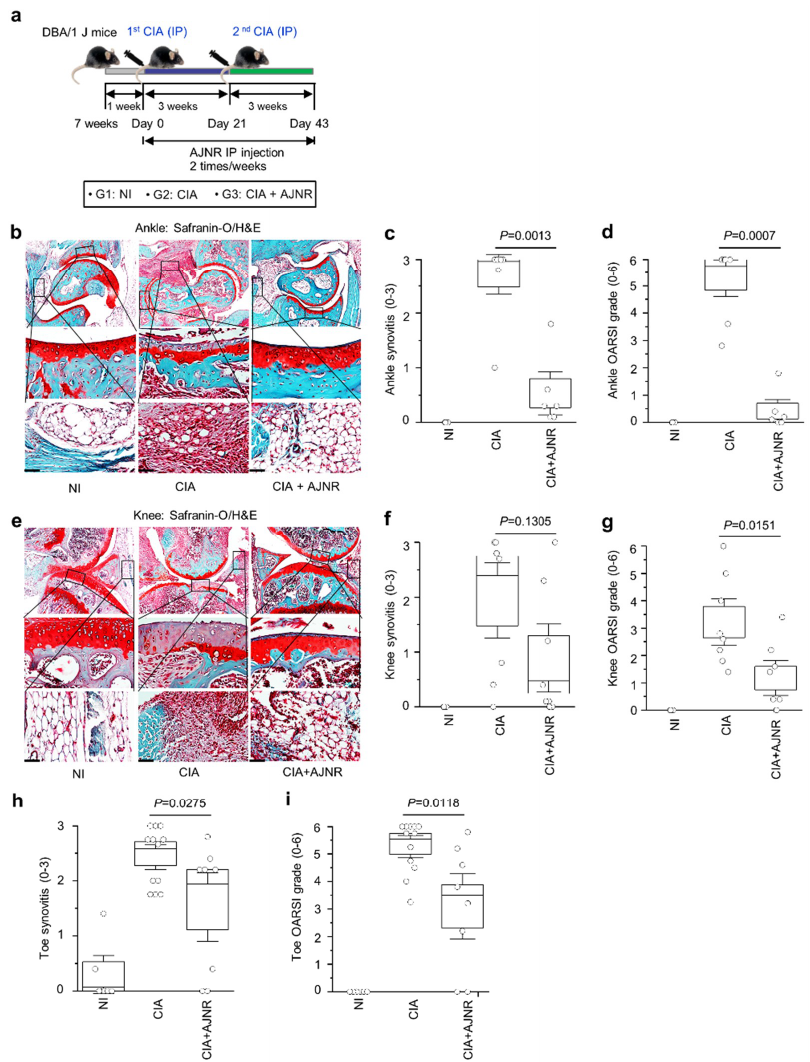
Figure 5. Inhibitory effects of AJNR against collagenase-induced arthritis (CIA)-induced cartilage degeneration and synovitis. First, CIA models were established using 10-week-old DBA/1 J mice. During arthritis induction, AJNR intraperitoneal (IP) injections were administered (2 times per week for 6 weeks). ( a ) The scheme of AJNR treatment in the CIA mouse model. ( b ) Representative Safranin-O and hematoxylin and eosin stain (H&E) staining images of ankle cartilage degeneration and synovial inflammation, respectively, in the non-immunized (NI), CIA, and AJNR-treated CIA mice. Scores of synovial inflammation ( c ) and Osteoarthritis Research Society International (OARSI) ( d ) in the ankle are presented ( n ≥ 4 mice per group). ( e ) Representative Safranin-O and H&E staining images of knee cartilage degeneration and synovial inflammation, respectively, in NI, CIA, and AJNR-treated CIA mice. Scores of synovial inflammation ( f ) and OARSI ( g ) in the knee are presented ( n ≥ 4 mice per group). Scores of toe synovitis ( h ) and OARSI ( i ) are also presented ( n ≥ 6 mice per group). The results are representative of three independent experiments. Values are presented as the mean ± SEM and were evaluated using the Mann–Whitney U test. Scale bar: 50 µ